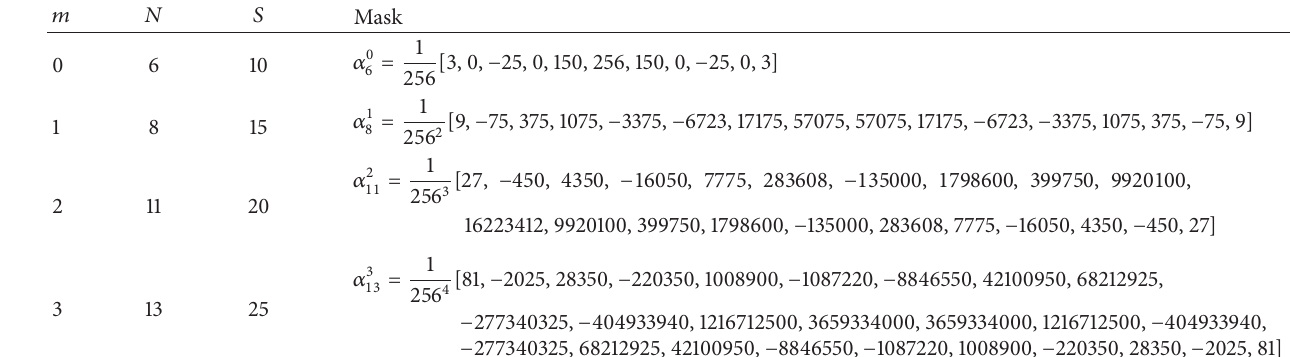
Table 1: Complexity, support, and mask of the 𝑞 -schemes corresponding to different values of 𝑚 , and here 𝑁 shows complexity of the schemes (i.e., 6-, 8-, 11-, and 13-point schemes) and 𝑆 stands for support width. 𝑚